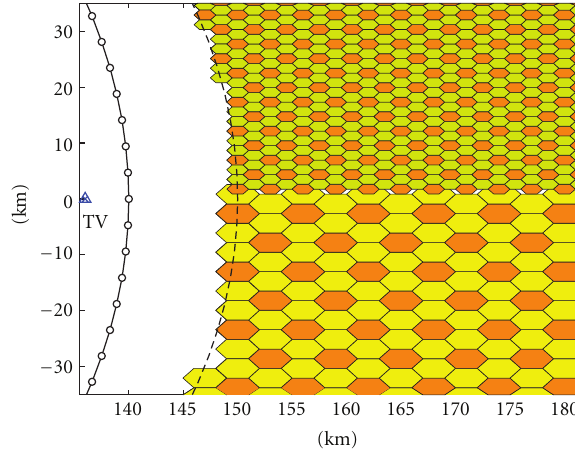
Figure 6: System illustration for di ff erent cell size coexistence case.